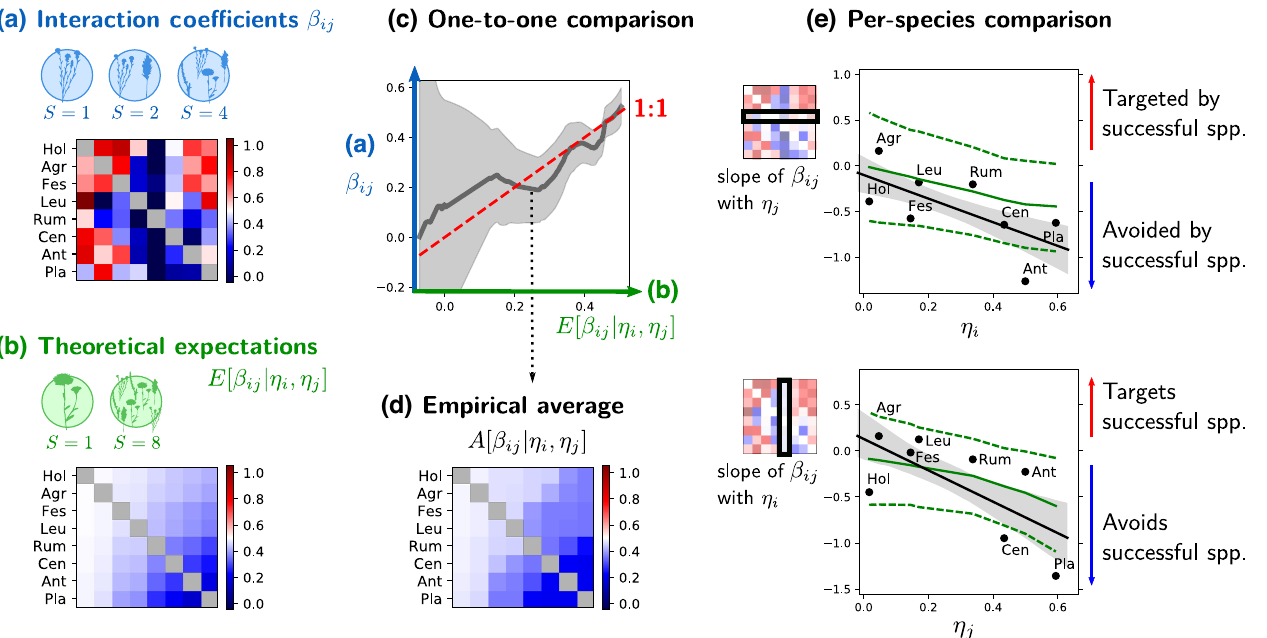
FIG. 5. Diffuse structure in the Wageningen grassland experiment. (a) Using many species combinations (56 sets of S < 8 species), we can fit interaction coefficients β in Eq. (2) by multilinear regression and compute their mean E ½ β (cid:2) ≈ 0 . 4 . (b) Using the relative yields η ij i in the full community ( S ¼ 8 species), we predict the theoretical pattern of expectations (4) for each interaction [Fig. 3(a); here we see ¯ β only negative biases in blue, indicating that all interactions are less competitive than the prior mean ]. Abbreviations for species names are given in Sec. IV. (c) – (e) In our diffuse pattern, individual coefficients are expected to exhibit a large spread around their expectation j η (cid:2) , and must be binned to compute empirical statistics. (c) We group coefficients β E ½ β ; η by their associated η , η to compute the ij i j ij i j j η (cid:2) (gray curve, (cid:4) 1 standard deviation in shaded area). Its proximity to the dashed 1 ∶ 1 line is one of multiple ; η running average A ½ β ij i j j η (cid:2) in matrix form (median value for each species ; η metrics of theory-data agreement. (d) We show the empirical running average A ½ β ij i j j η (cid:2) in (b). This is a particular way of smoothing the empirical matrix β ; η pair i , j ), to be compared with the theoretical prediction E ½ β ij i j ij shown in (a); see Sec. IV. (e) In another test of the theory, we group coefficients by species, i.e., either by row or by column in the matrix β . We then compute how coefficients in row i (column j ) vary with η ( η ). Each solid point is the linear regression slope within a row or ij j j column. The empirical values and their spread around the trend are both in good agreement with our theoretical predictions (mean trend in solid line, spread in dashed lines, (cid:4) 1 SD). The linear slope of the points matches quantitatively the theoretical trend in the mean, which is approximately linear as expected for large S